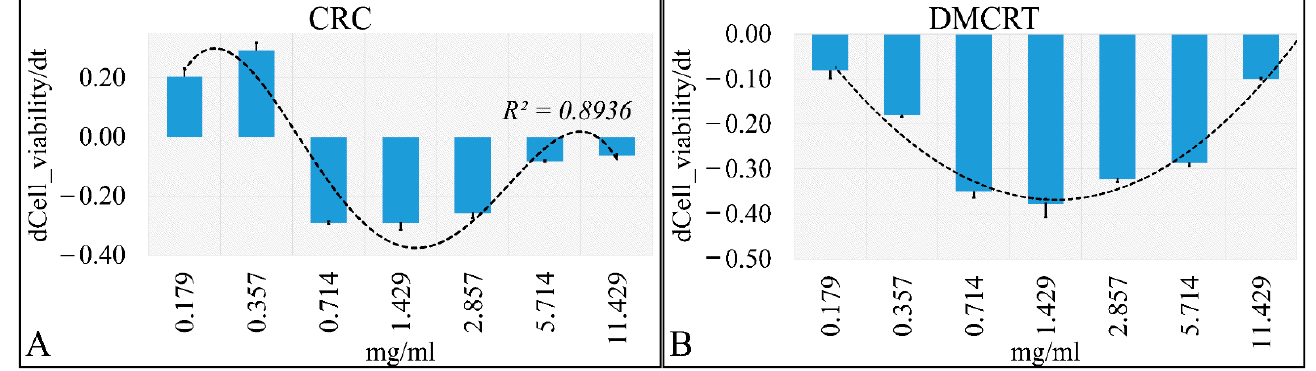
Figure 11. Calculation of IC 50 of CRCs and DMCRT on TE671 cells. IC 50 were found 1.84 mg/mL ( R 2 = 0.99), 1.52 mg/mL ( R 2 = 0.99) and 1.02 mg/mL ( R 2 = 0.98), for CRCs, at 24, 48 and 72 h, respectively ( A ). In addition, the IC 50 for DMCRT was estimated to be 2.44 mg/mL ( R 2 = 0.98), 1.81 mg/mL ( R 2 = 0.98) and 1.27 mg/mL ( R 2 = 0.98) at 24, 48 and 72 h, respectively ( B ). 3.3.5. Gene Expression under CRCs and DMCRT on Rhabdomyosarcoma Cells (TE671)